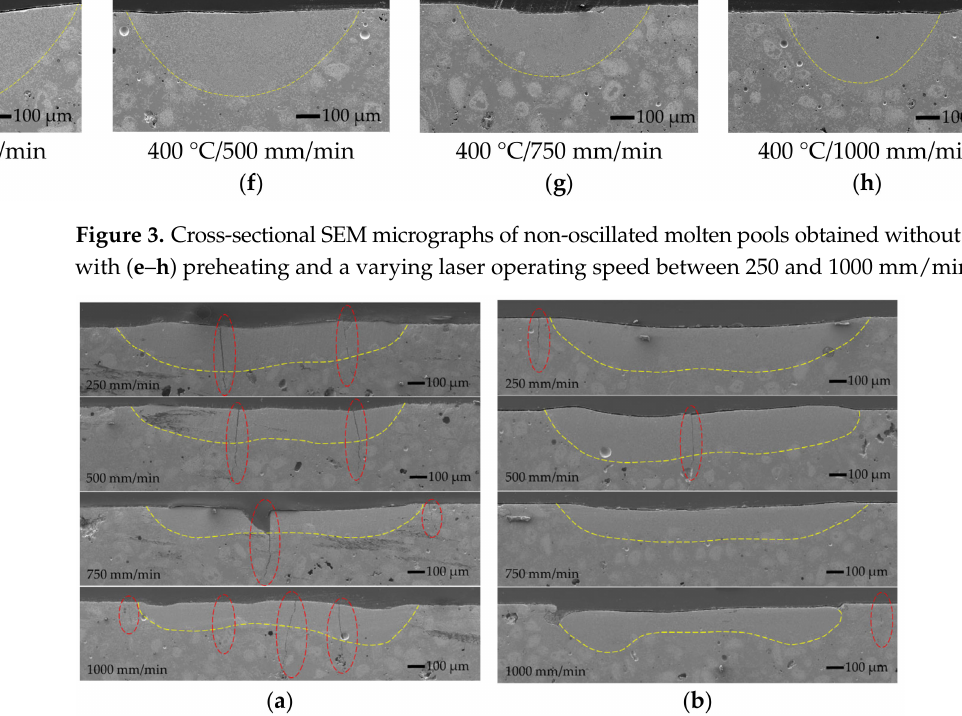
Figure 4. Cross-sectional SEM micrographs of molten pools oscillated with 1 mm amplitude without ( a ) and with ( b ) preheating and a varying laser operating speed between 250 and 1000 mm/min: red dotted ovals show the